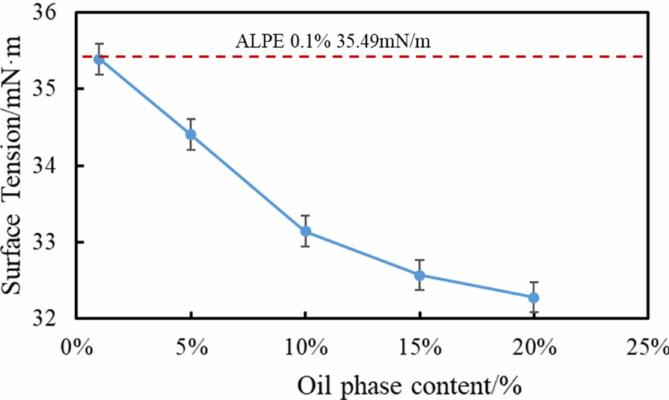
Figure 9. Relationship between surface tension and oil phase content when the nanoemulsions concentration is 0.1%.